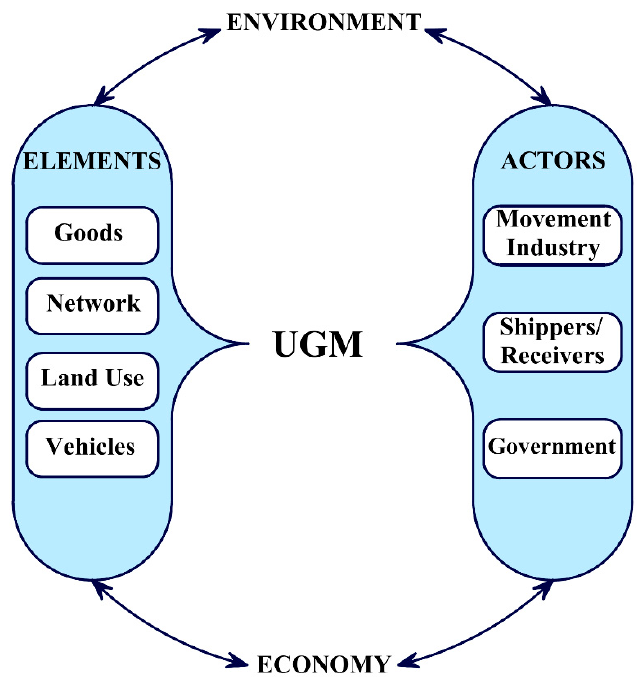
Figure 8. The reciprocal relationship between ‘elements’ and ‘actors’(Source: [79]). Freight Traffic